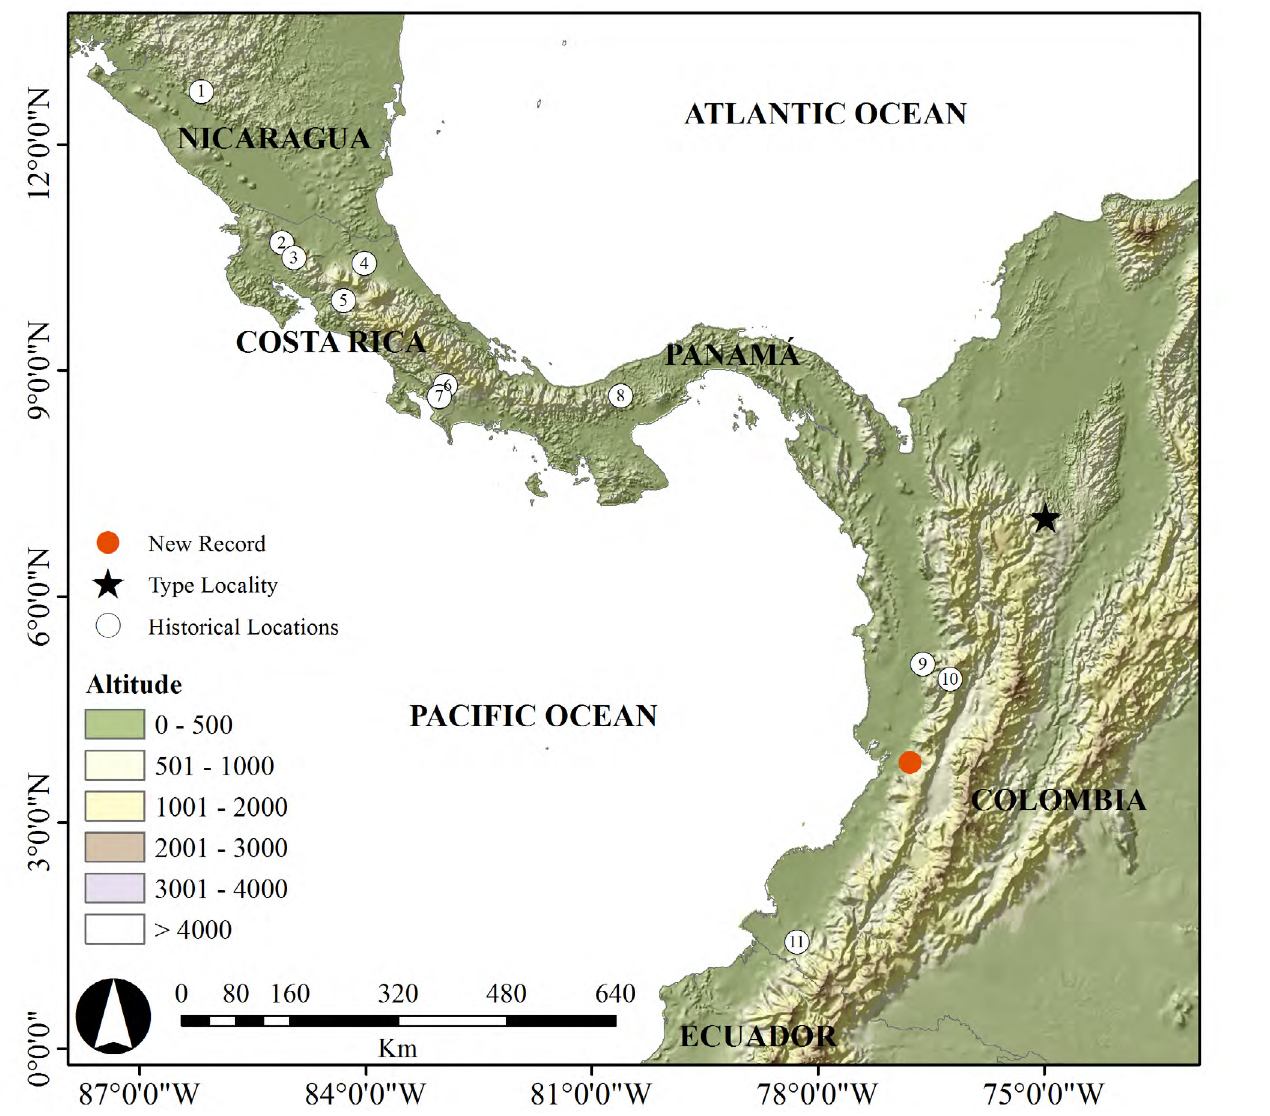
Figure 2. Geographic distribution of Tantilla alticola . The black star indicates the type locality (BMNH 1946.1.6.63-65, Antioquia, Colombia), black circles historical records: 1, 2, 7. Estimated from Wilson (1986) (Myers et al. 2013); 3. LACM 147598, Guanacaste, Costa Rica; 4. LACM 147597, Heredia, Costa Rica; 5. KU 30995, Cartago, Costa Rica; 6. LACM 125561, Puntarenas, Costa Rica; 8. Coclé, Panamá; 9. BMNH 1946.1.8.83-84 - BMNH 1913.11.12.60-61, Condoto, Chocó, Colombia 10. San José del Palmar, Chocó, Colombia; 11. ICN 10857, Nariño, Colombia. The red circle indicates the new record from La Delfina, municipality of Dagua, along road between Cali and Buenaventura, department of Valle del Cauca, western Colombia Valle del Cauca,